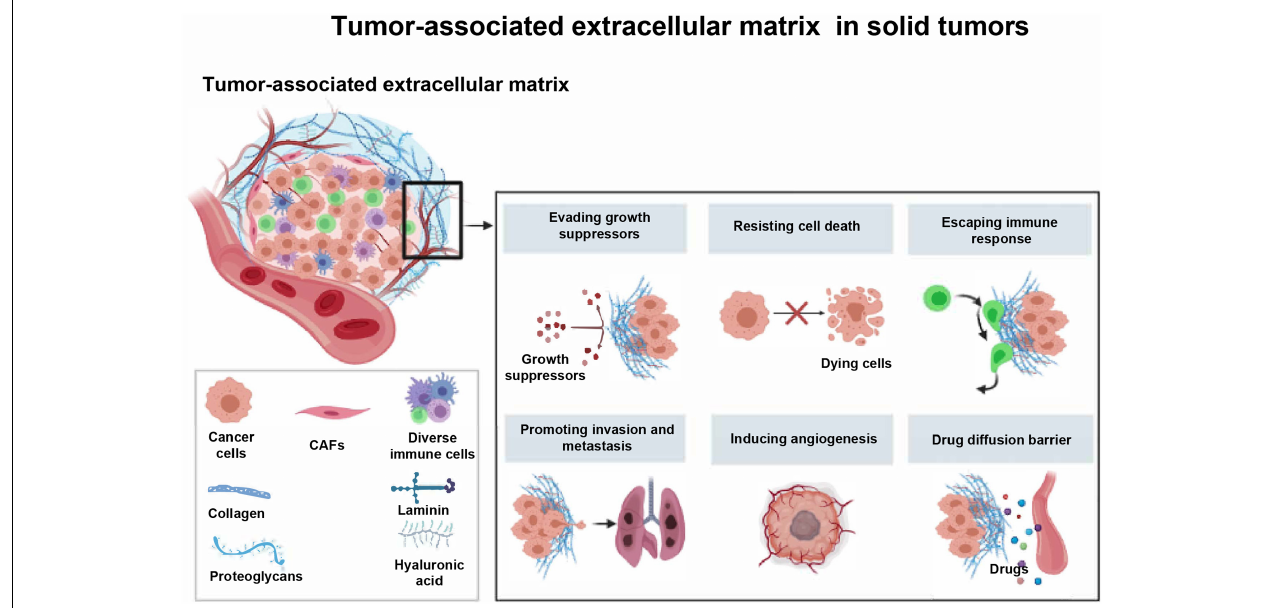
FIGURE 1 | The major components and roles of tumor-associated extracellular matrix in solid tumors. The tumor-associated ECM has been considered as a newly formed network that is essential for the protection of tumor cells and promotion of tumor progression. CAFs, cancer associated fibroblasts.